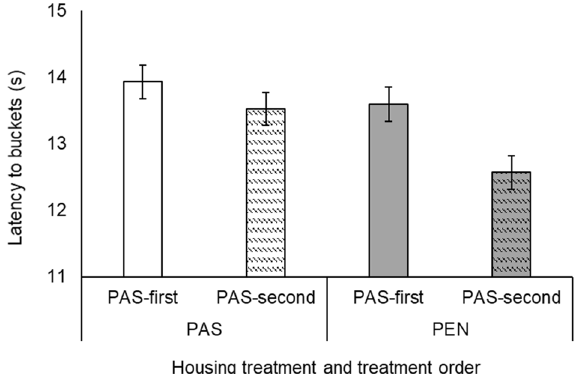
Figure 2. Interaction between housing treatment (pasture access: PAS; cubicle housing: PEN) and treatment order (PAS-first, PAS-second) in response latency to all five bucket locations. Error bars represent standard error of the mean.